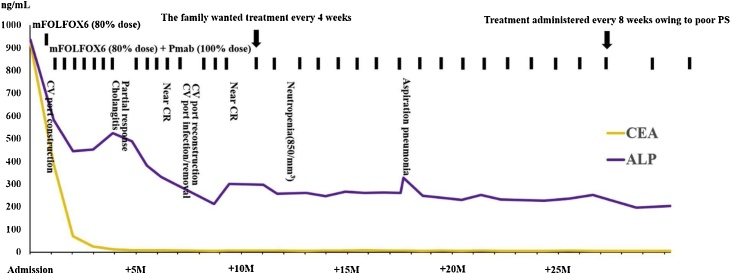
Clinical course.